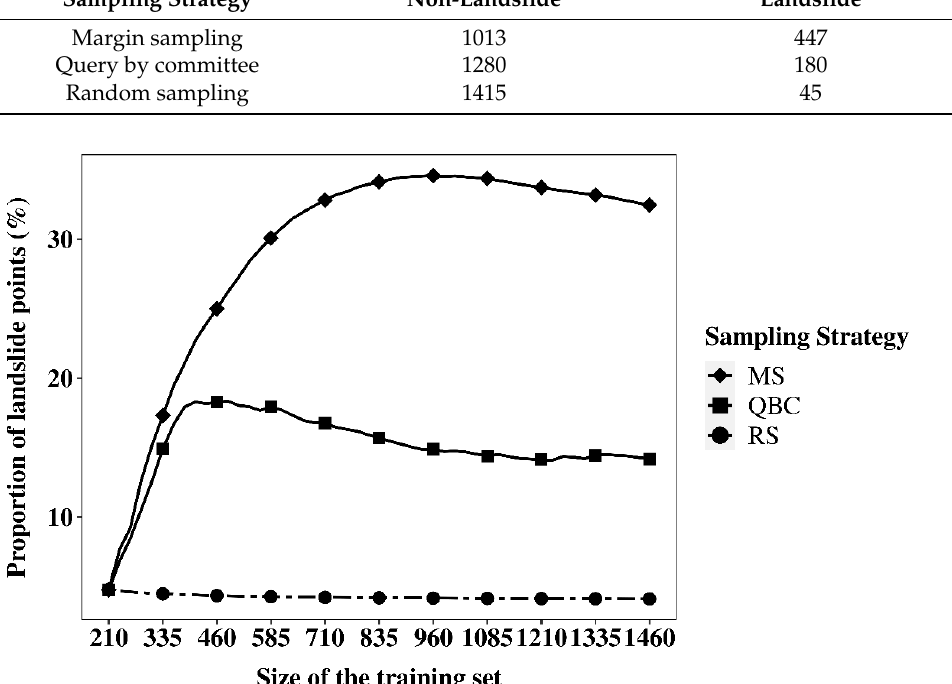
sampling Figure 9. Number of landslide instances in the training set in each epoch using SVM with different sampling strategies.